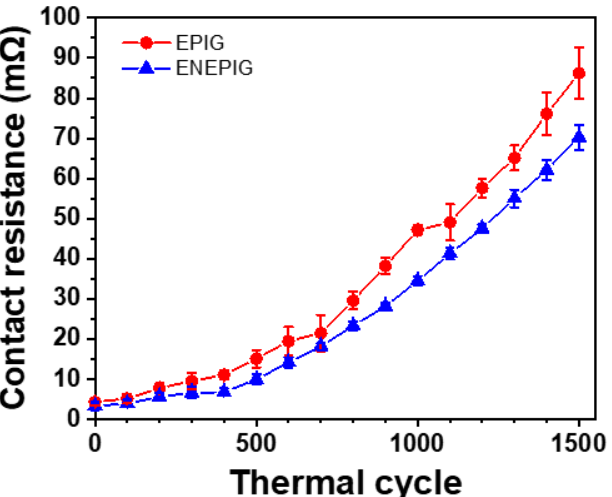
Figure 11. Contact resistance of Cu/SnAg pillar bump joints on surface finishes, EPIG and ENEPIG.